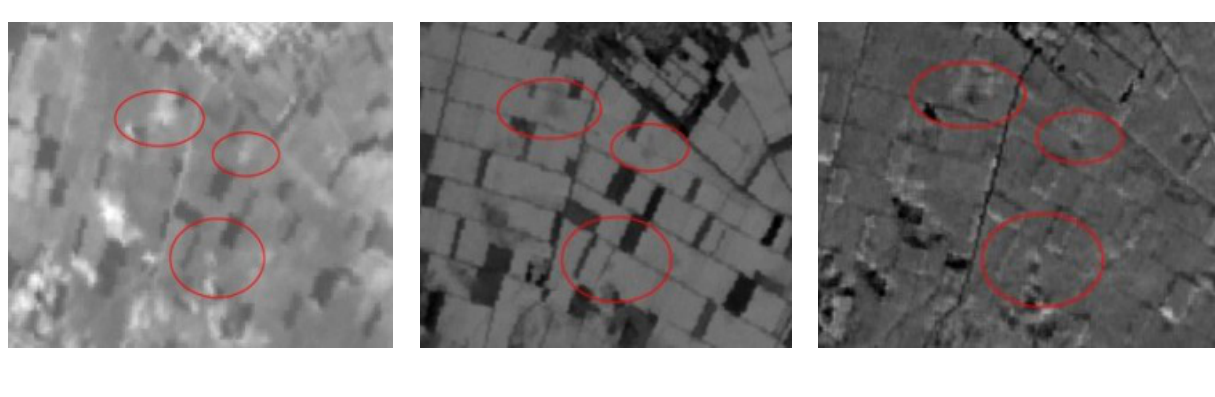
Figure 8 . Appearance of three settlements to the first Principal Component of ASTER image (left). Appearance of three settlements to the second Principal Component of ASTER image (middle). Bottom Appearance of three settlements to the third Principal Component of ASTER image (right